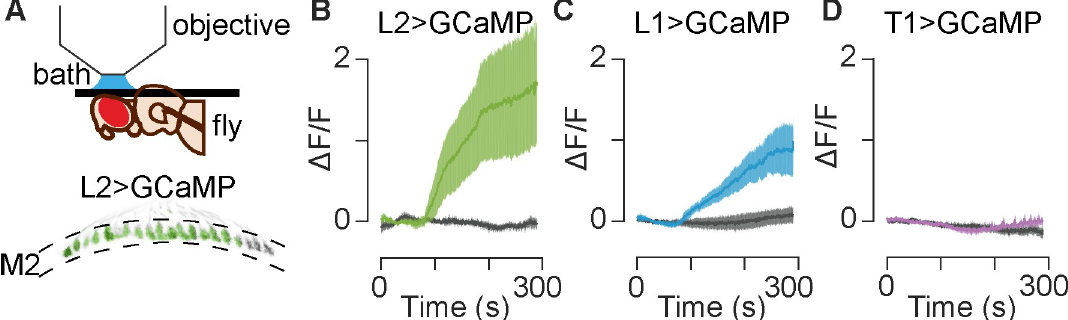
Fig 4. Bath application of serotonin leads to increased calcium in L2 and L1 neurons, but not T1 neurons. ( A ) The experimental setup is shown in the top of panel A, along with a sample image of L2 terminals (bottom of panel A, gray) as imaged in the medulla. The ROIs are overlaid in green. ( B-D ) GCaMP6f was paired with L2, L1 and T1 split-GAL4 drivers to monitor responses to 100 μ M serotonin (colored traces) or saline controls (gray traces). The perfusion change occurred approximately 105 s into the recording, which corresponds to 45 s in (B-D) because the first 60 s are not shown. ( B ) In L2 terminals, serotonin application led to a significant increase in GCaMP6f signal indicating increased calcium levels as compared to saline controls (p = 00095). ( C ) L1 terminals showed a similar increase in calcium following a switch to serotonin (p = 0.02). ( D ) T1 cells expressing GCaMP6f showed no significant change in calcium following serotonin application (p > 0.05). For (B-D) N = 4–8 individual flies; the dark trace is an average of all traces and the shaded region is 1 SEM; saline vs. serotonin comparisons are two-tailed Wilcoxon rank sum tests.